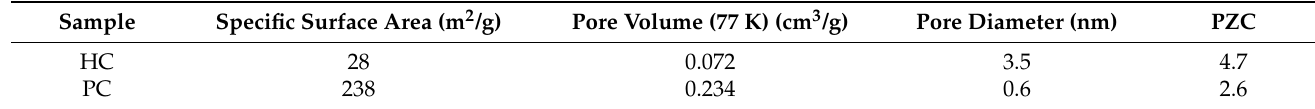
Table 2. Textural properties and PZC of HC and